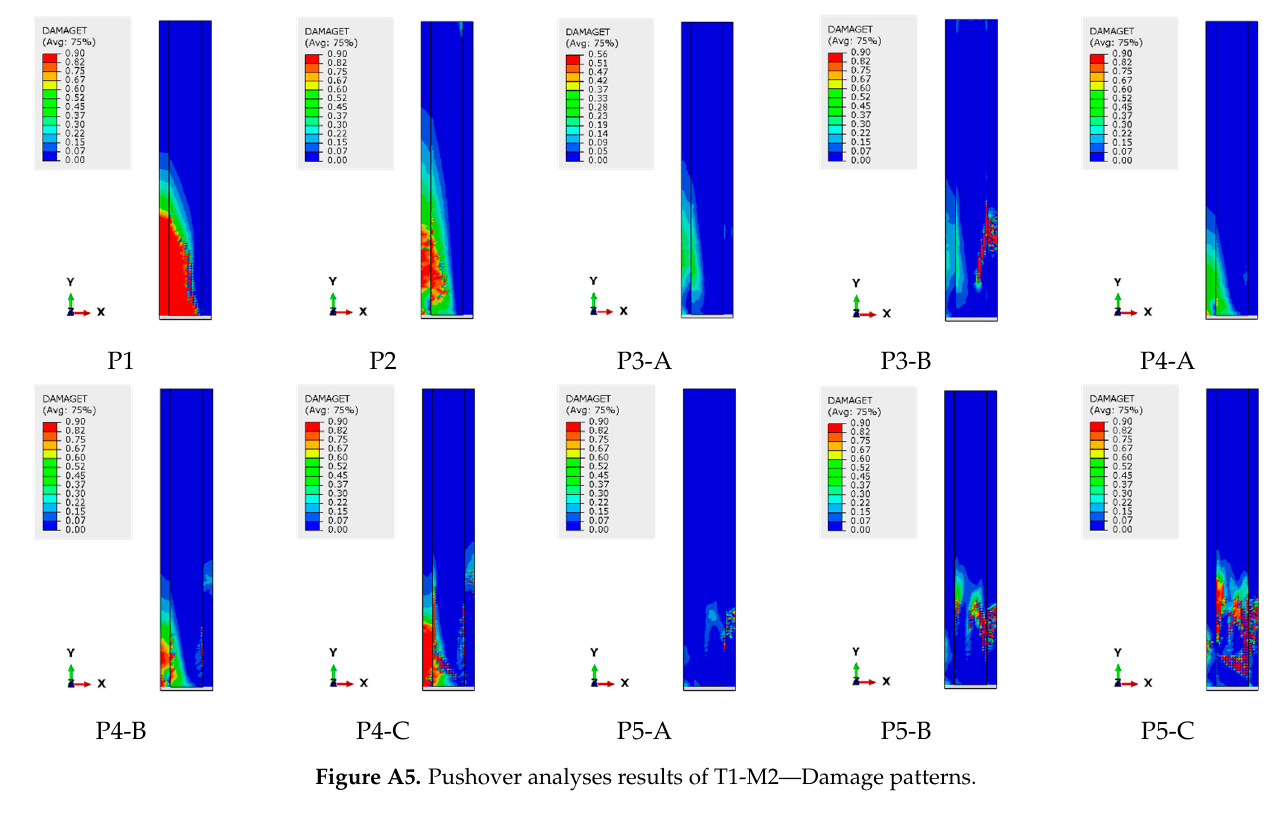
Figure A5. Pushover analyses results of T1-M2—Damage patterns. Figure B2. Pushover analyses results of T1-M2—Damage patterns. Figure B2. Pushover analyses results of T1-M2—Damage patterns.